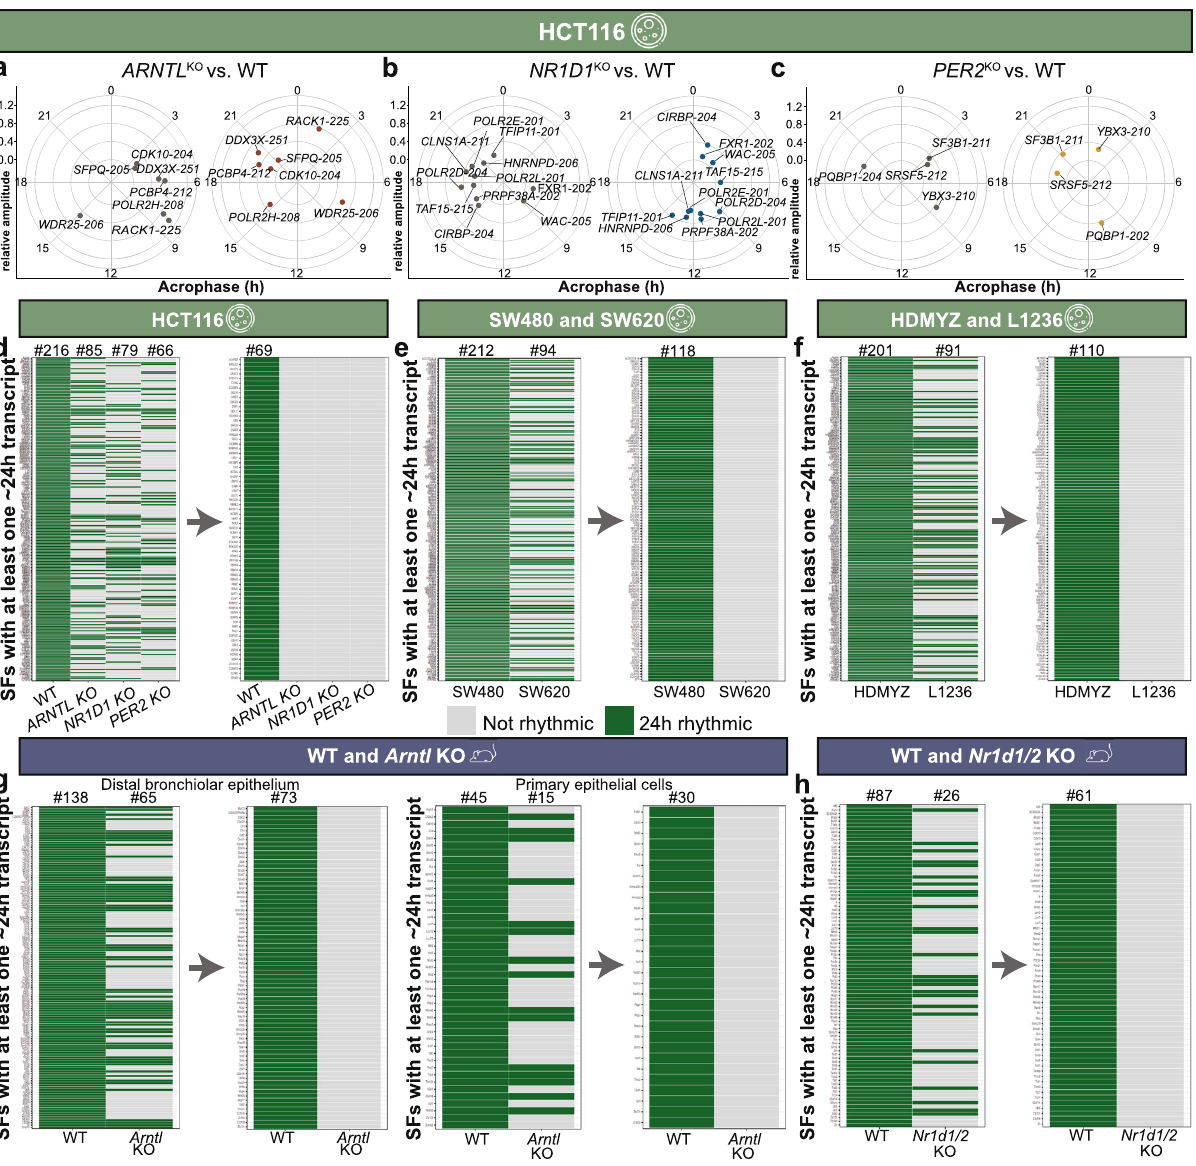
Fig. 3 Clock disruption affected rhythmicity of splicing factors in human and murine datasets. a – c Circular plots depict the distribution of peak phases of overlapping differentially rhythmic SF transcripts between ( a ) HCT116_WT and HCT116_ ARNTL KO , ( b ) HCT116_WT and HCT116_ NR1D1 KO , and ( c ) HCT116_WT and HCT116_ PER2 KO . d – h Categorial heatmaps represent the loss of rhythmic SFs in ( d ) HCT116 KO vs. WT, ( e ) SW620 vs. SW480, ( f ) L1236 vs. HDMYZ, ( g ) mouse Arntl KO vs. WT in distal bronchiolar epithelium (left) and primary epithelial cells (right), and ( h ) Nr1d1/2 KO vs. WT. Green colour indicates SFs with at least one ~24 h transcript whereas grey colour indicates SFs with no rhythmic transcript. The numbers above the categorial heatmaps indicate the total number of SFs (genes) with rhythmic according to whether or not they contained transcripts with protein-coding biotype. All AS events in HCT116 KO cells except for the AF-event in HCT116_ NR1D1 KO and HCT116_ PER2 KO showed higher number of genes present in the loss of splicing events vs. gain of splicing events (Fig. 4a – c). However, a large increase in the number of genes with AF-gain was observed in both HCT116_ NR1D1 KO (gain vs. loss: 75.8% vs. 24.4%) and HCT116_ PER2 KO (gain vs. loss: 74.2% vs. 25.7%) (Fig. 4b – c). Interestingly, higher number of genes with gain in splicing events were observed in the metastasis CRC cell line (SW620) and in stage IV HL cell line (L1236) (Fig. 4d – e). We further investigated if the same genes were alternatively spliced through AF-event (gain) in both HCT116_ NR1D1 KO and HCT116_ PER2 KO . Subsequently, we